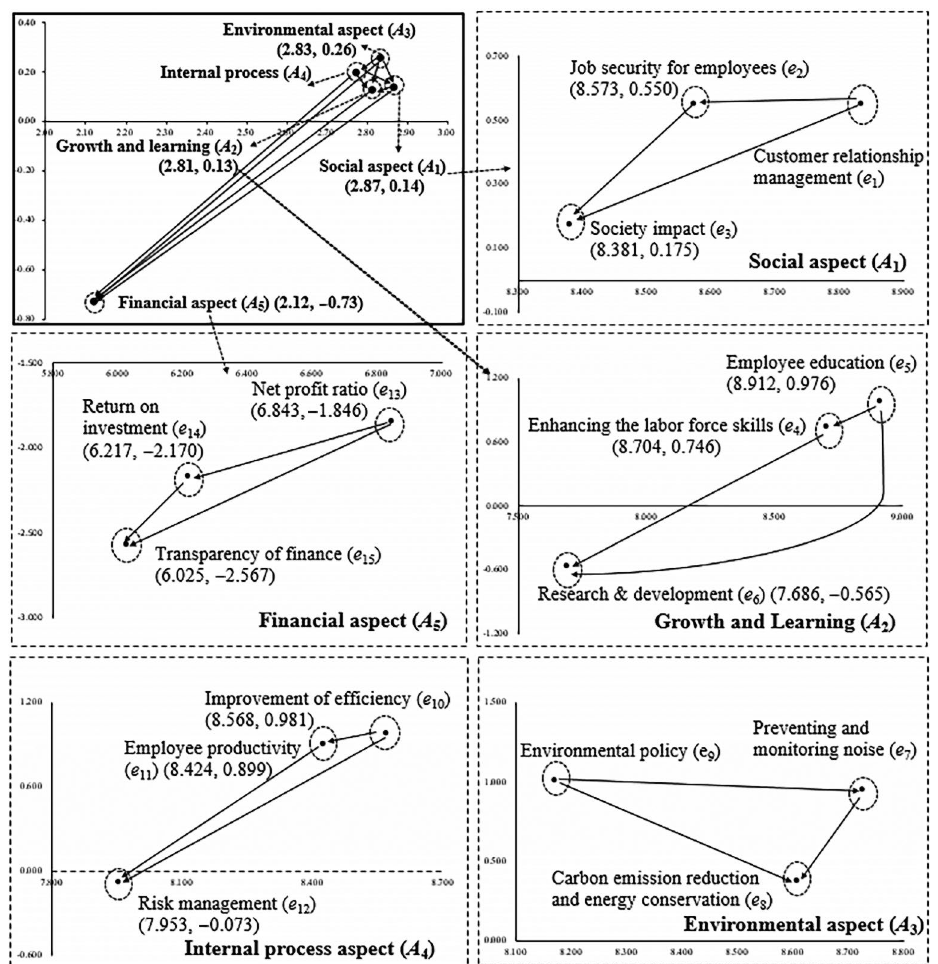
Figure 1. The fuzzy INRM per aspect and